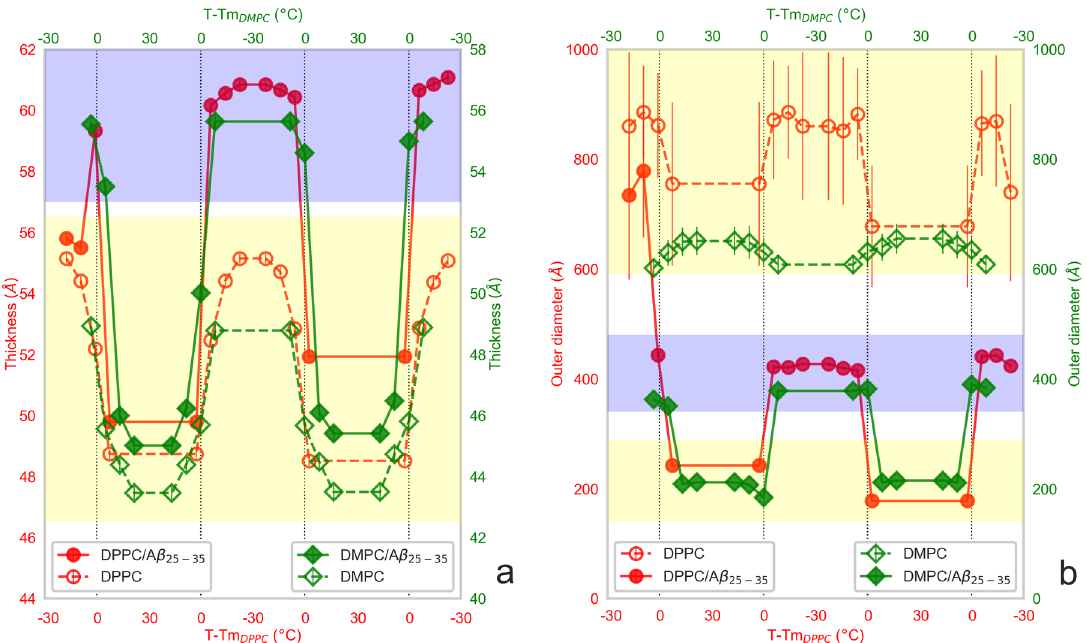
Figure 2. The membrane thicknesses ( a ) and outer diameter of lipid aggregates ( b ) obtained for the systems based on DPPC (red color; left and bottom axes) or DMPC (green color; right and top axes) as a function of reduced temperature relative to main transition (Tm DPPC = 41 °C and Tm DMPC = 24 °C). The order of points from left to right corresponds to the chronology of SANS measurements. The neat lipid systems are shown by open symbols and those with the addition of Aβ 25–35 by solid ones. The vertical lines mark the phase transitions for neat lipid systems as reported in the literature. The horizontal shaded areas demarcate the structural forms of membranes by yellow color in the case of ULVs (EULVs and/or SULVs), and by blue color in the case of